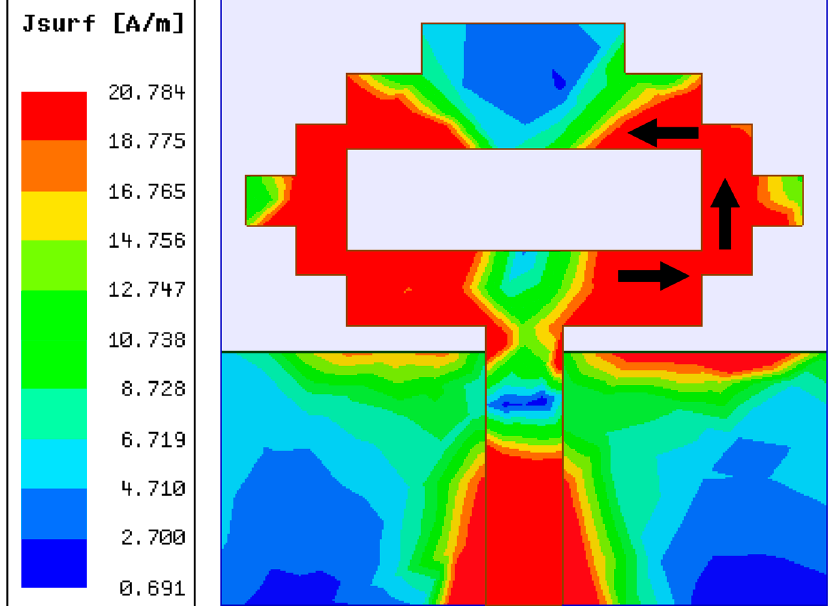
Figure 3. Single antenna element’s current distribution at 4.75 GHz.